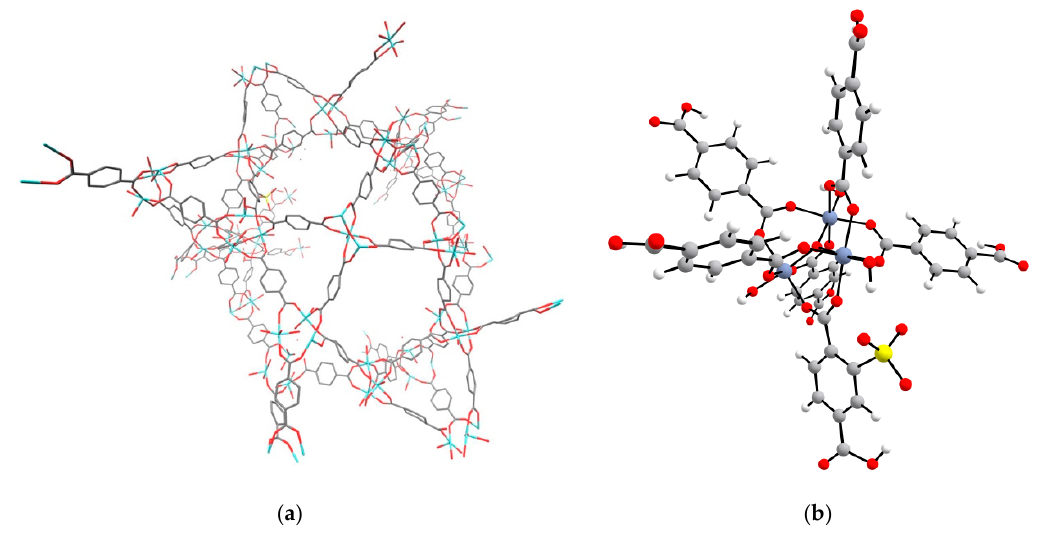
Figure 1. ( a ) Snapshot of the X-ray for the metal organic framework (MOF) (Cr)MIL-101-SO 3 − (Na · 15-crown-5) + [26], and ( b ) with the addition of the catalyst AquaMet TM as part of the MOF.